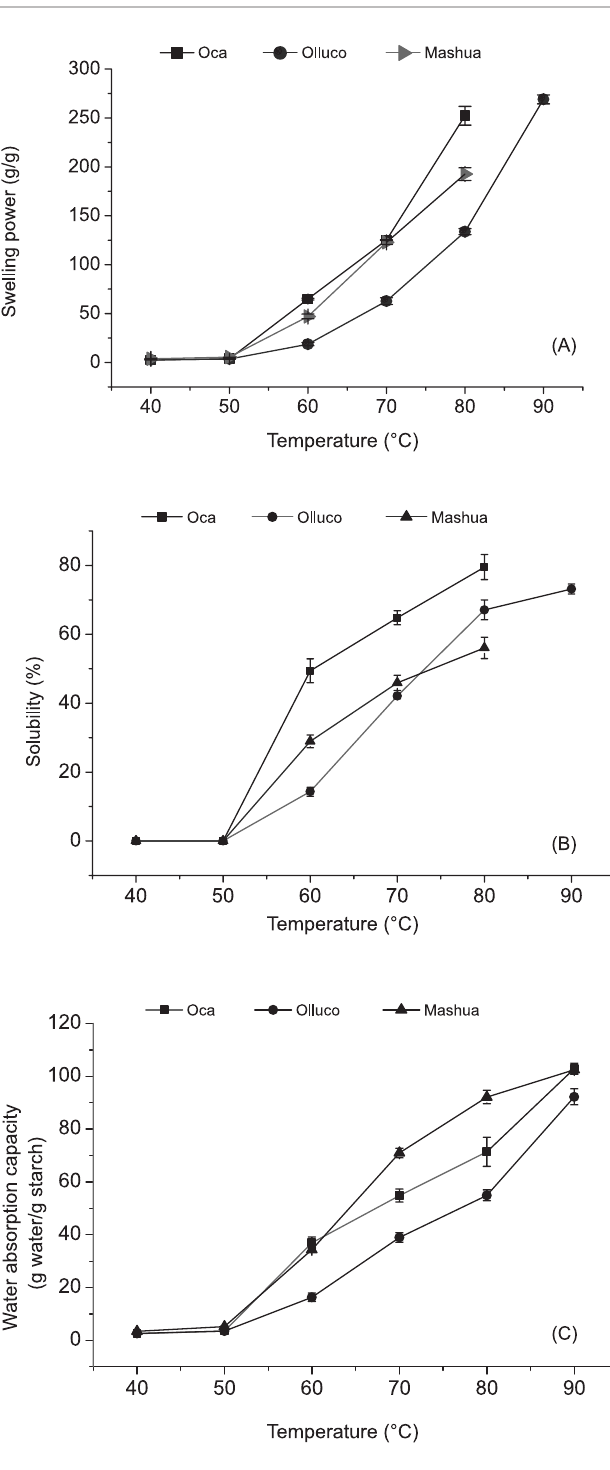
FIGURE 2 - Comparative hydration curves of oca, olluco and mashua starches as a function of temperature. (A): Swelling power, (B) Solubility and (C) Water absorption capacity.